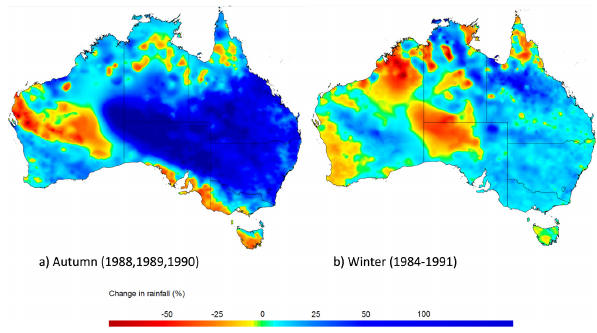
Figure 6. Difference in (a) autumn and (b) winter rainfall during “wet seasons” compared to the long-term mean